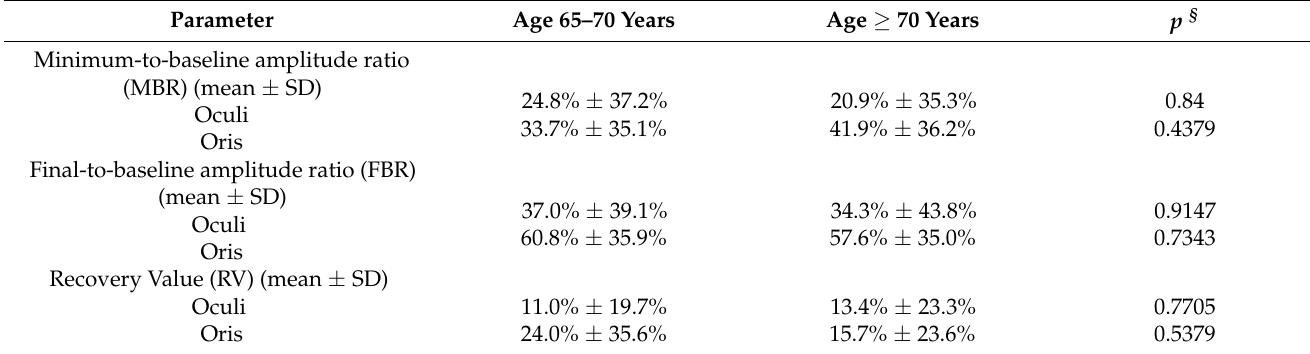
Table 2. Corticobulbar facial motor evoked potentials (FMEP) indices.